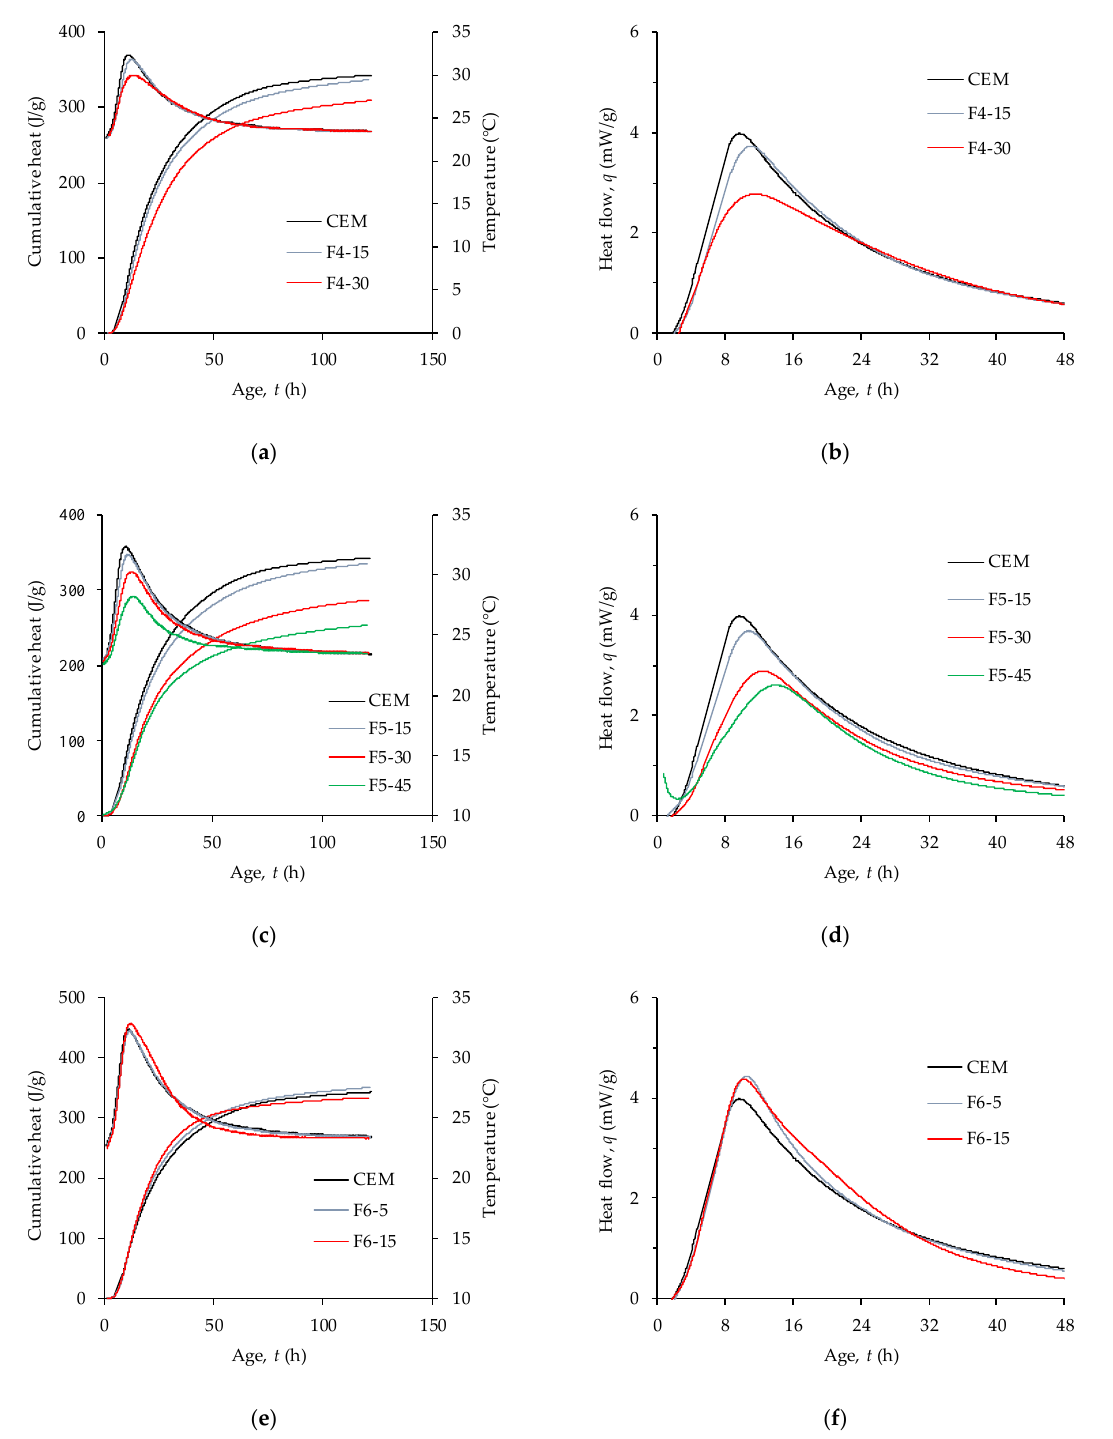
Figure 6. Temperature, heat flow, and cumulative heat measured on concrete specimens: ( a , b ) comparison between reference mix and mixes containing WFA F4; ( c , d ) comparison between reference mix and mixes containing WFA F5; ( e , f ) comparison between reference mix and mixes containing WFA F6.